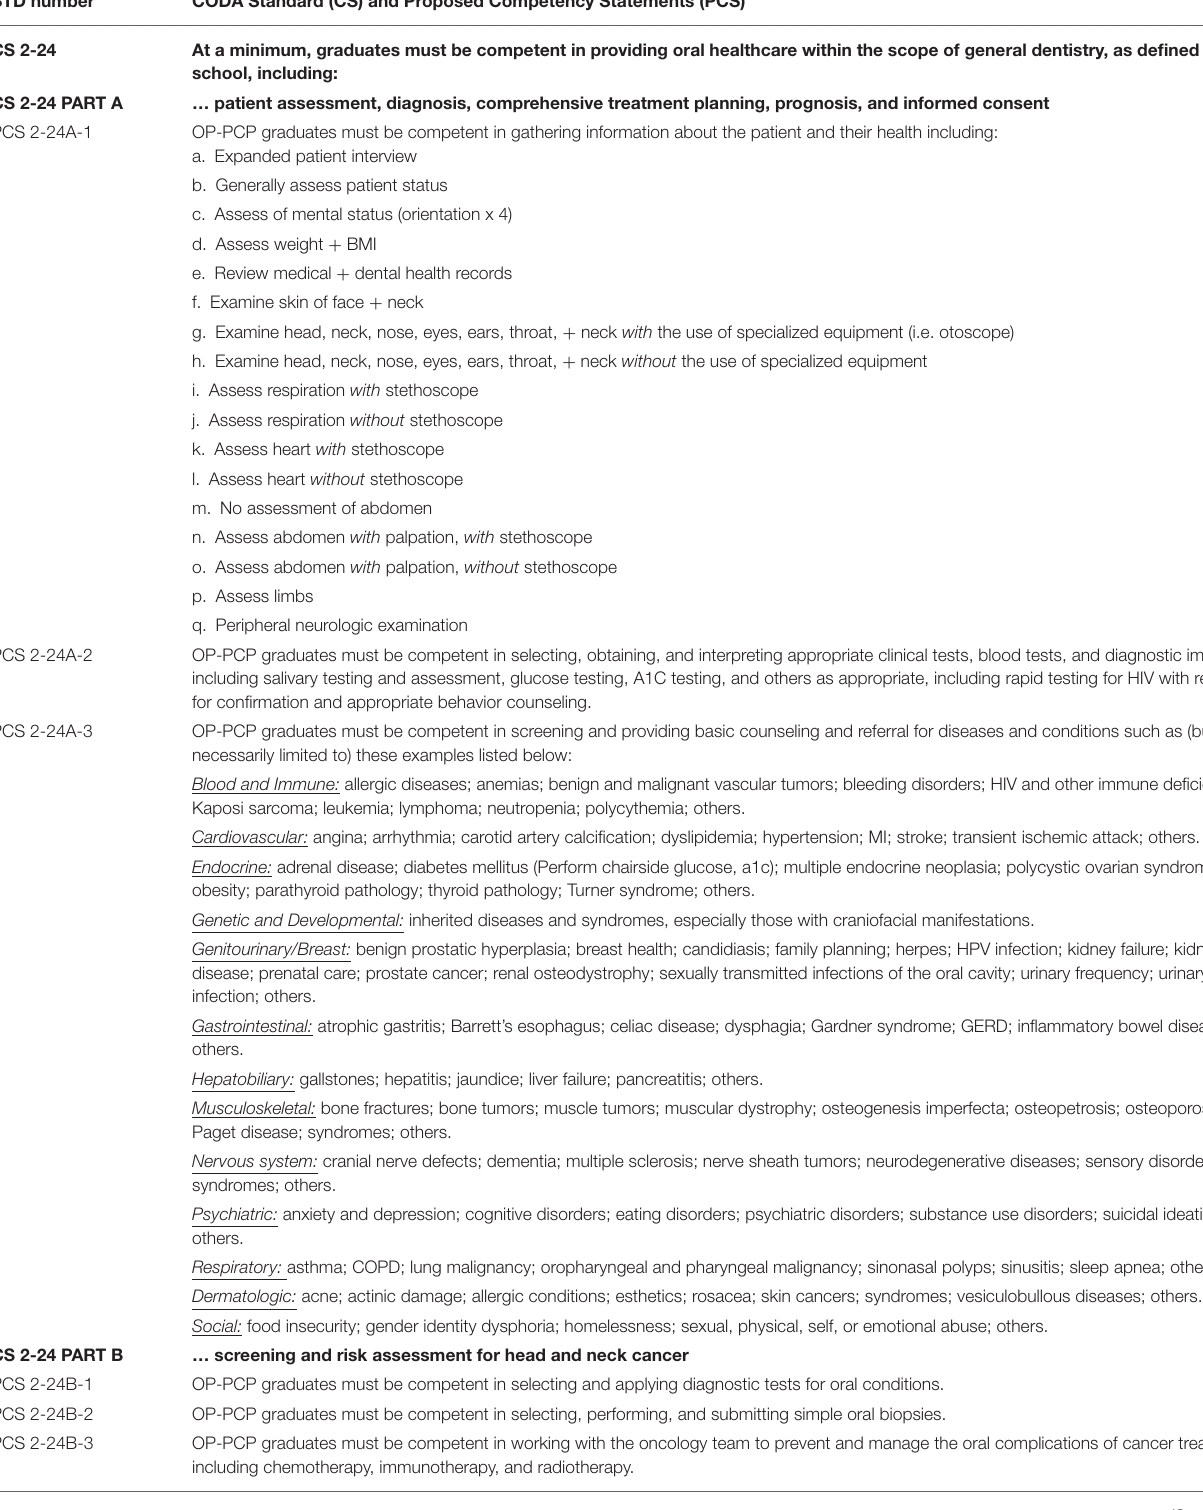
TABLE 2 | CODA Standard (CS) 2-24 only, and related Proposed Competency Statements (PCS) for Oral Physician – Oral Health Primary Care Provider (OP-PCP). STD